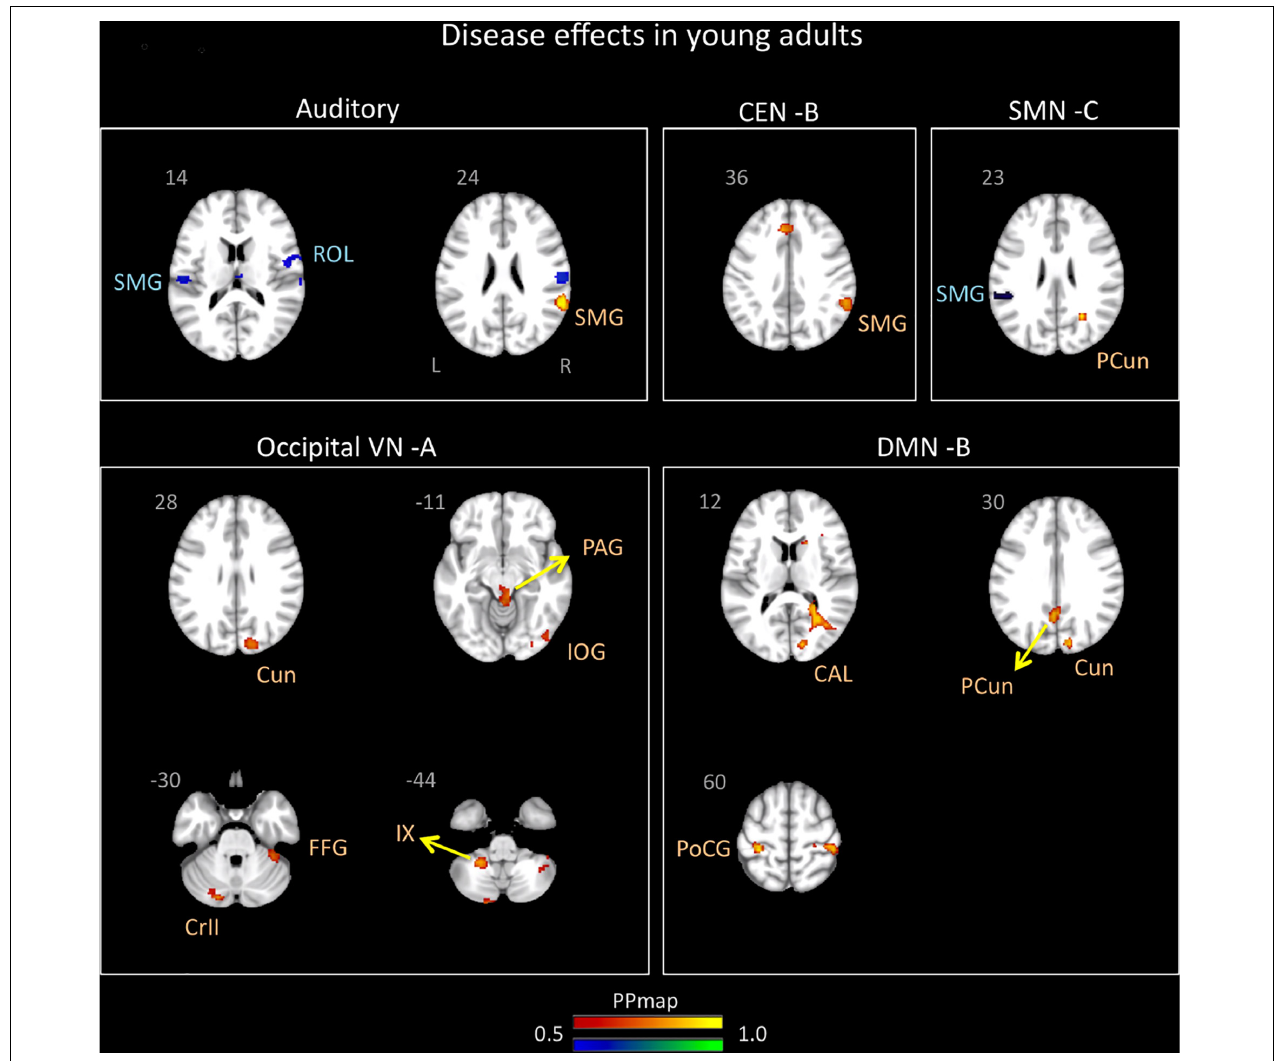
FIGURE 3 | Disease effects on rs-FC networks in the young adults group vs. healthy controls. The figure summarizes the statistically significant changes in connectivity measured between young adult migraineurs and their healthy controls. Changes were found in the auditory, central executive B, sensorimotor C, occipital visual A, and default mode B networks. See text for further details and Table 5 . Numbers refer to the standard MNI Atlas coordinates. Abbreviations of brain regions are described in Table 8 . Red – Yellow: Increased connectivity in young adult migraineurs vs. controls. Blue – Green: Decreased connectivity in young adult migraineurs vs.